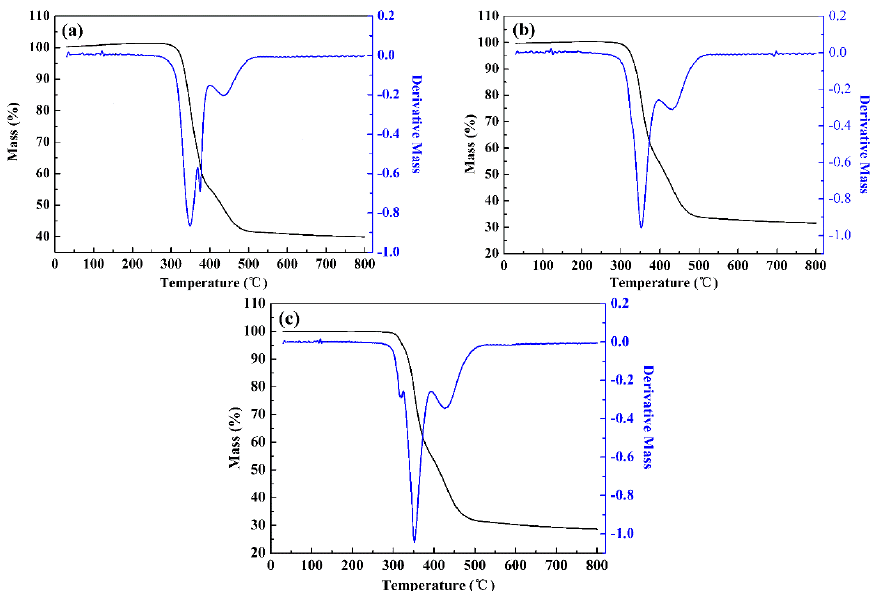
Figure 10. TG (black) and DTG (blue) curves of PBPE-1 ( a ), PBPE-2 ( b ) and PBPE-3 ( c ).